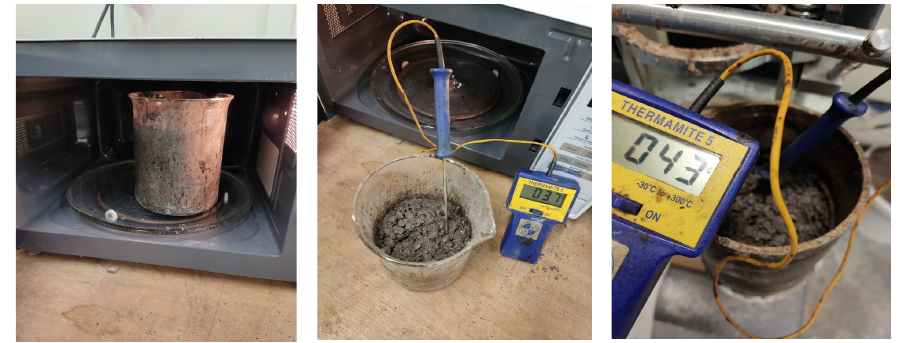
Figure 1. Microwave process.